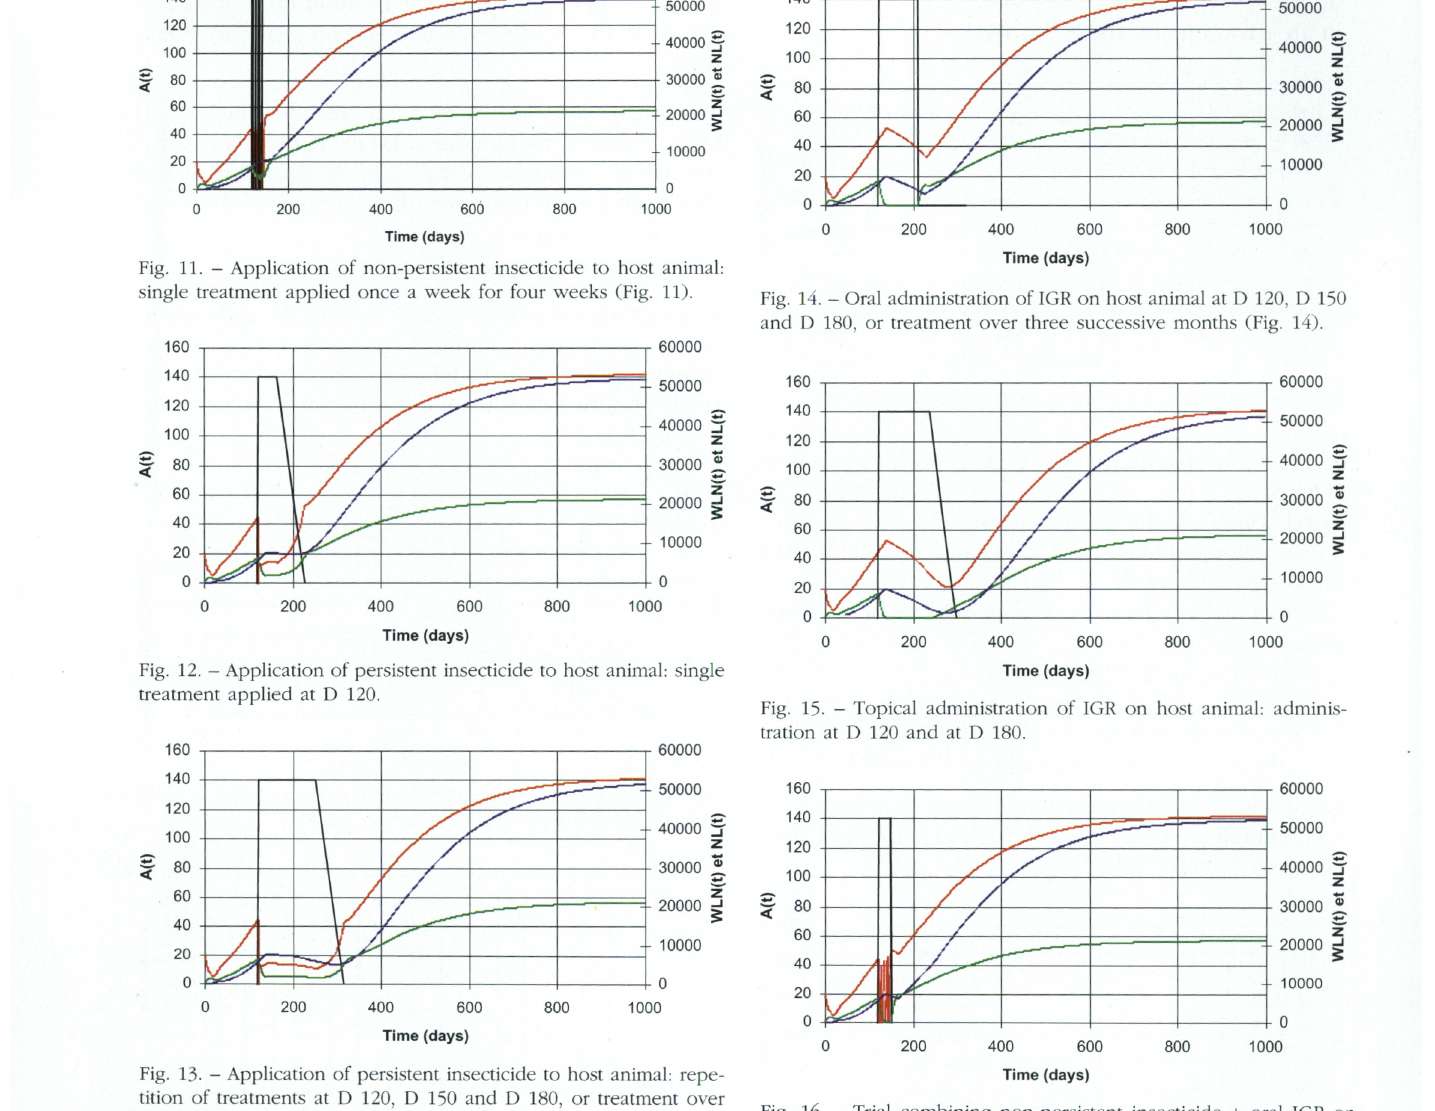
Fig. 16. - Trial combining non-persistent insecticide + oral IGR on host animal: use of non-persistent insecticide three days running each week for one month, with parallel oral administration of IGR.